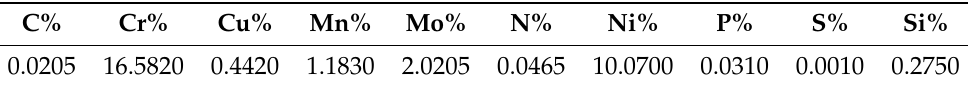
Table 1. ASTM A751/14a chemical analysis of 316 stainless-steel